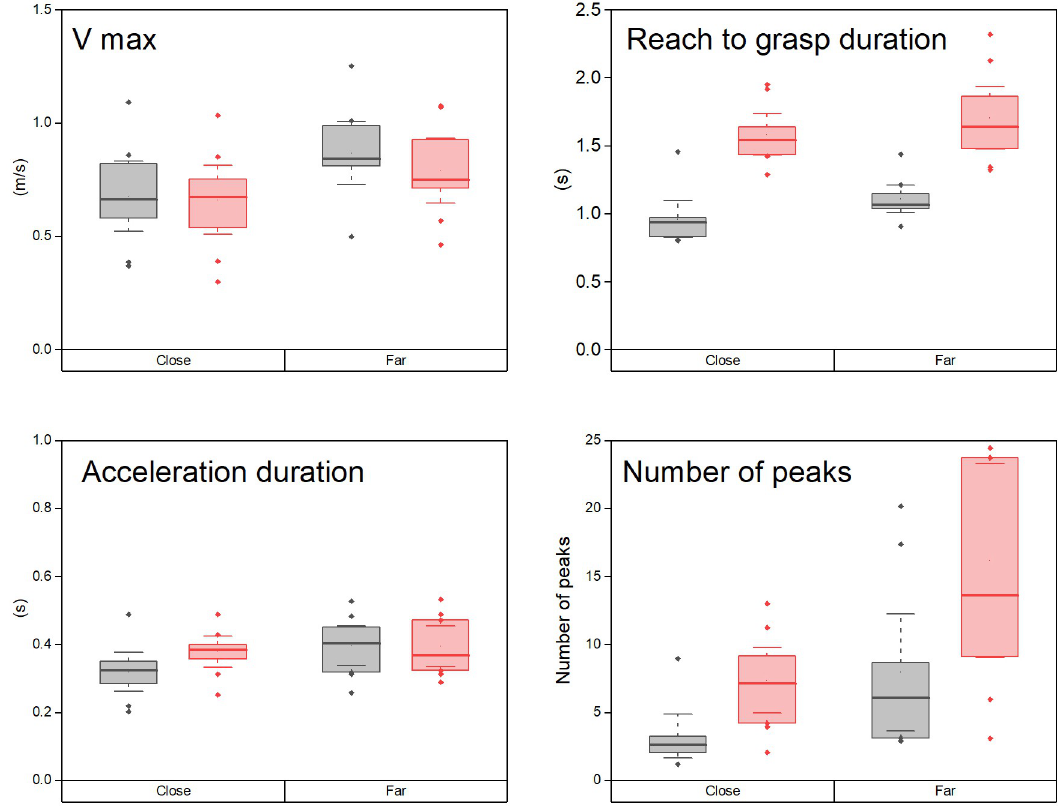
Fig 4. Box plots comparing the temporal variables during reaching between the non-amputated (grey) and prosthetic (red)